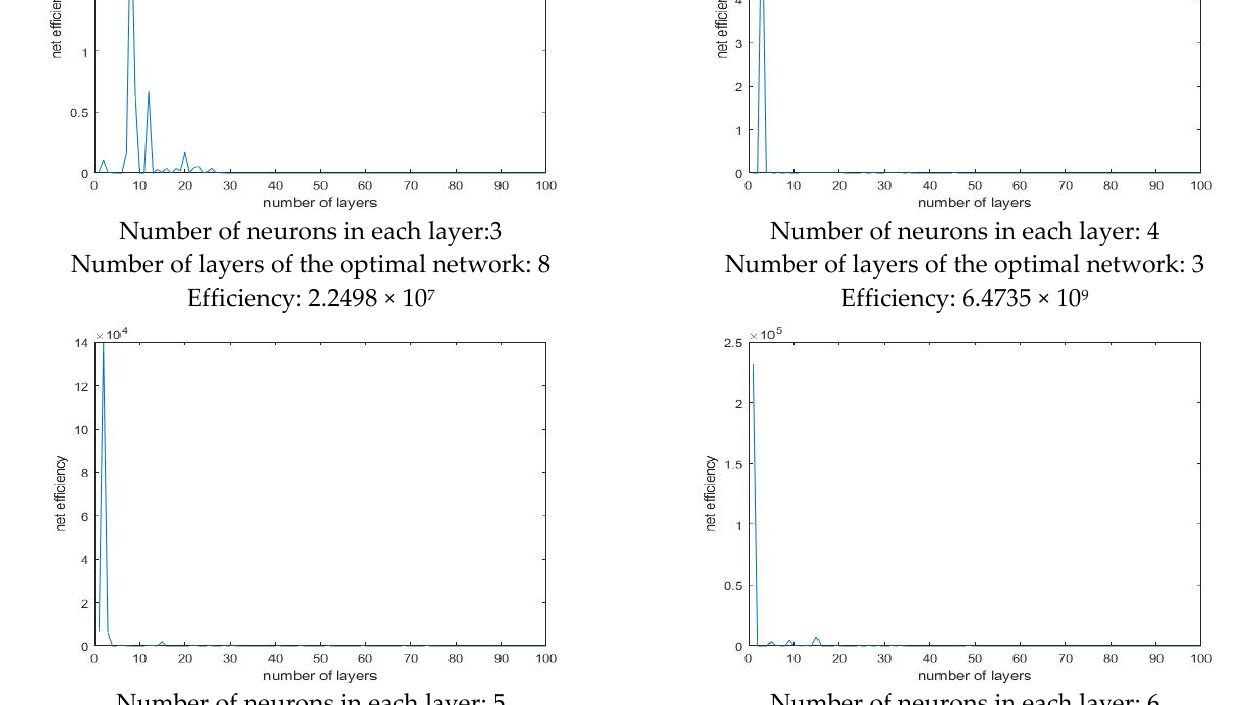
Figure 2. Optimal number of layers in neural networks approximating y = 2 x 1 + 3 x 2 +